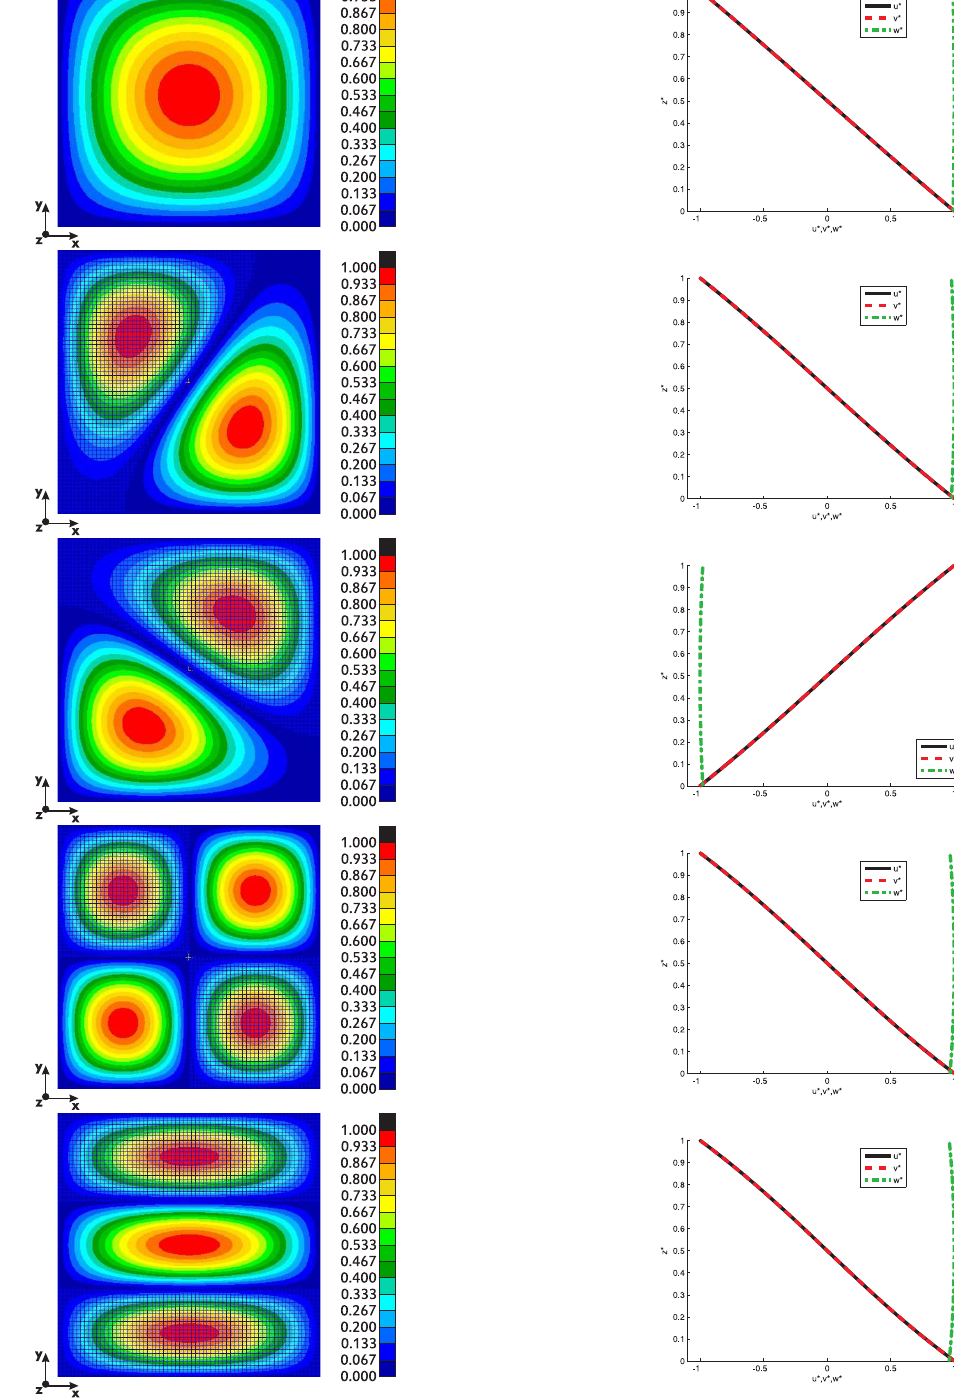
Figure 10: First benchmark, simply supported plate made of aluminium alloy with thickness ratio a/h=10. First five frequencies (with trans- verse displacement w ≠ 0) via 2D FE solution (on the left) and via 3D exact solution (on the right).